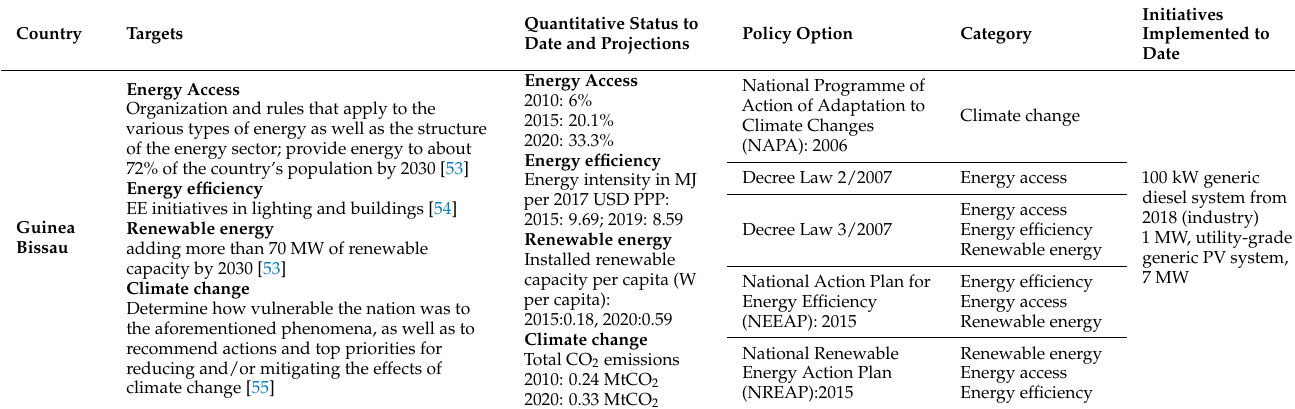
Table 8. Guinea Bissau (data from [22–24]).